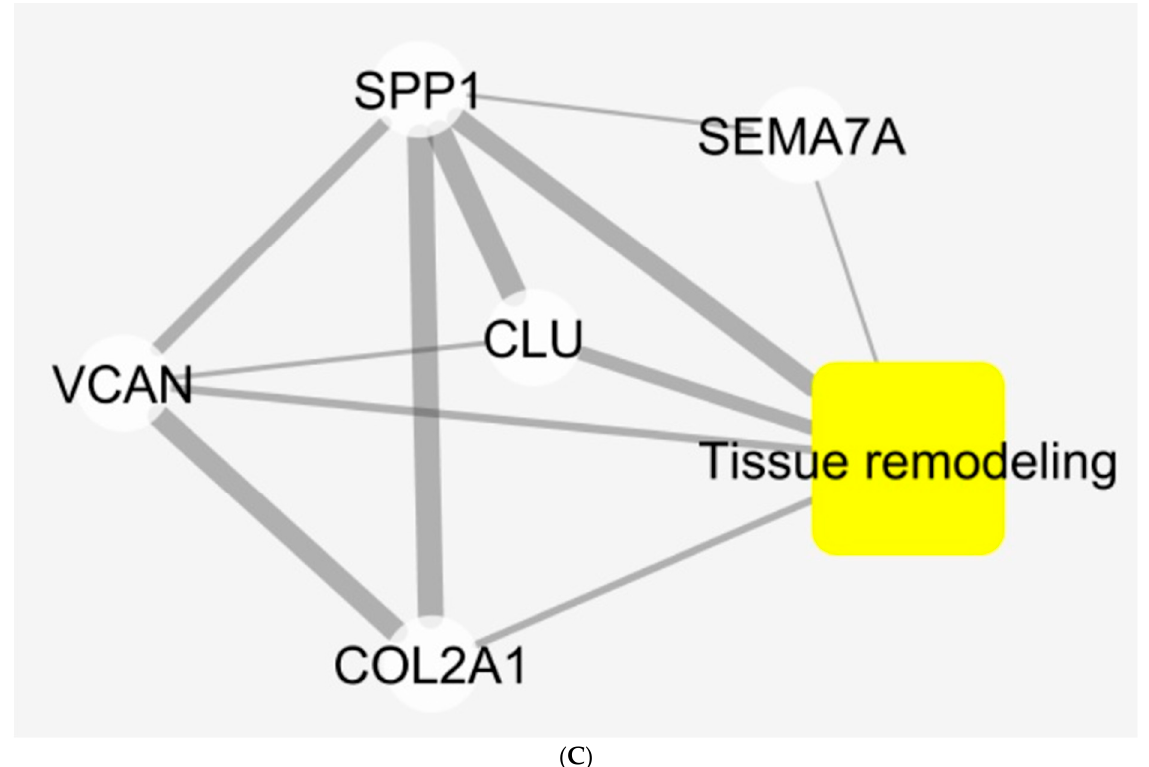
Figure 5. Literature and pathway analysis. ( A ) A total of 382 differentially expressed (DE) proteins were analyzed using a literature analysis with a focus on PVR diseases pathways. Node size correlates with number of connections. Line width correlates with mutual information between nodes. ( B ) A total of 268 proteins were uniquely present in the PVR groups compared with RD with no PVR, and ERM or MH groups were analyzed by ingenuity pathway analysis (IPA) with a focus on PVR diseases pathways. ( C ). From the literature analysis, SPP1, CLU, VCAN, COL2A1, and SEMA7A that are significantly upregulated in PVR were related to tissue remodeling.